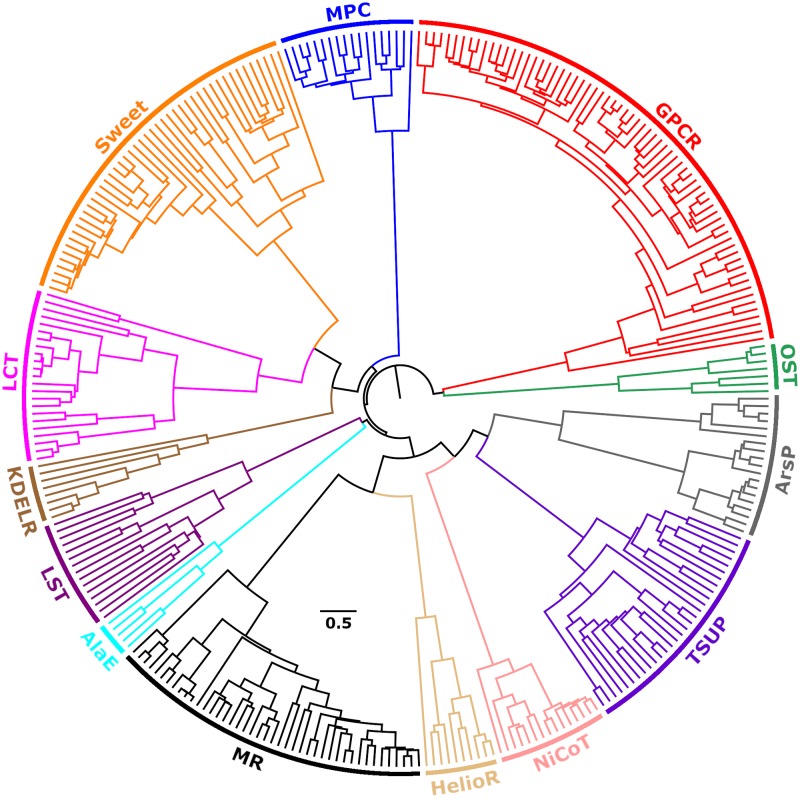
Radial tree of protein sequence similarities within the TOG superfamily.Different families are represented with different colors. The tree was generated with the program mkProteinClusters [1] based on Smith-Waterman bit scores of pairwise alignments (agglomerative coefficient: 0.88; see Methods). The original tree in Nexus format used to generate the figure is available in S3 File.